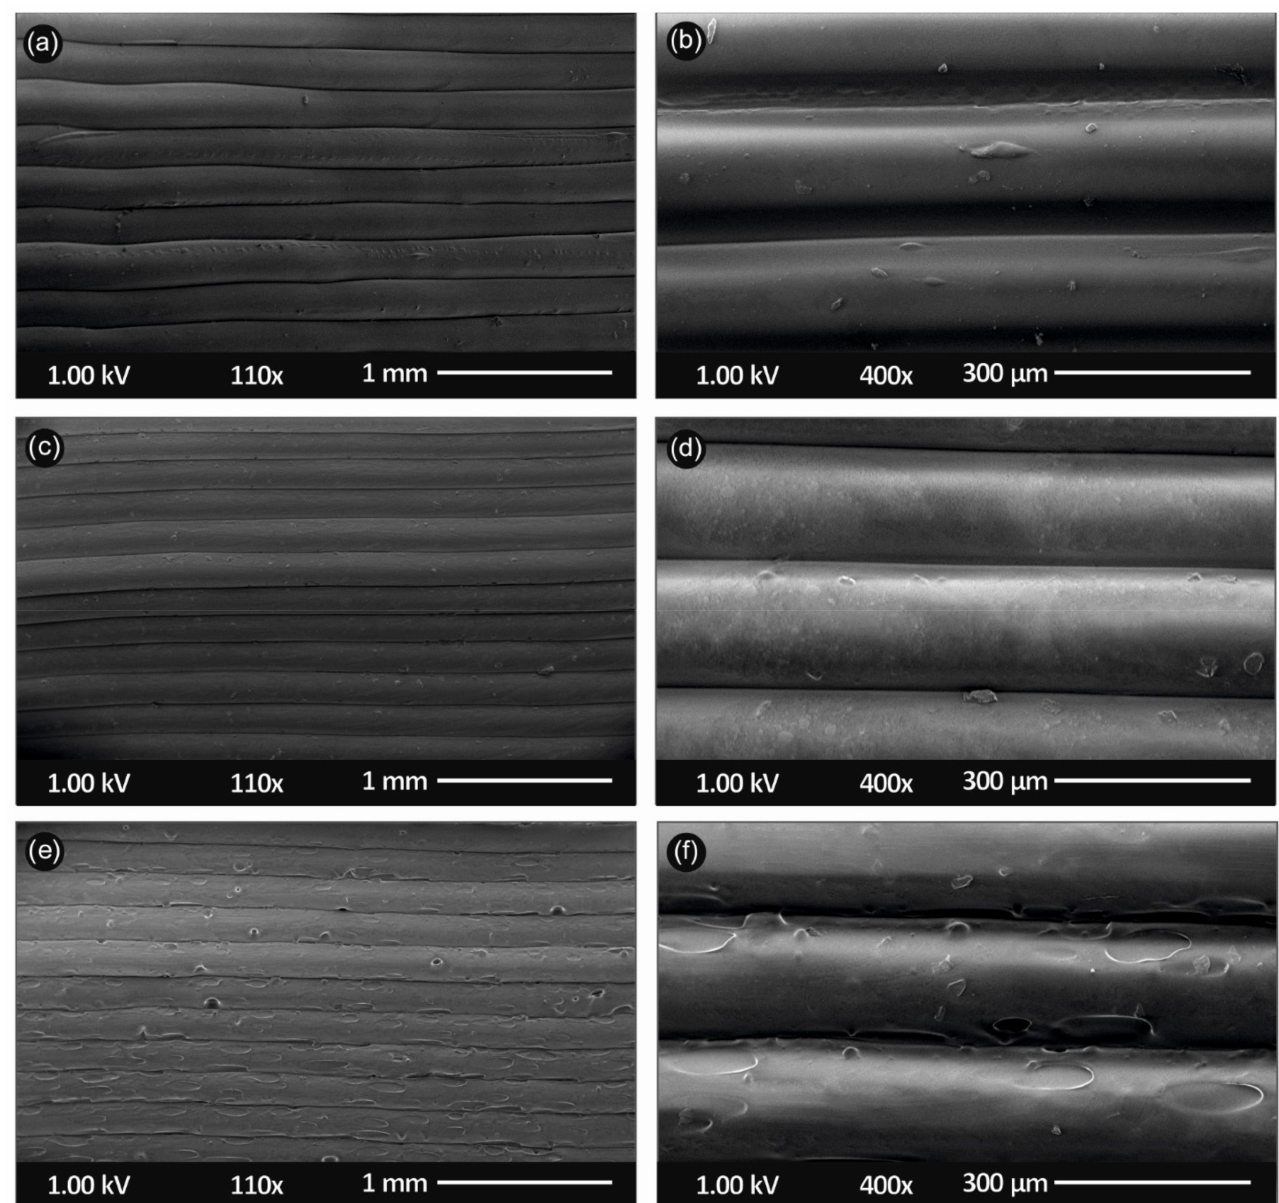
Figure 9. Scanning electron microscopy (SEM) images of the side-surface microstructure and morphology for the different 3D printed samples in this study at two different magnifications (all 3D printed samples with 300 µ m 3D printed layer thickness): SEM images at 110 × and 400 × magnification for the ( a , b ) pure PLA, ( c , d ) PLA/SiO 2 (1.0 wt.%) and ( e , f ) PLA/SiO 2 (4.0 wt.%) nanocomposites,